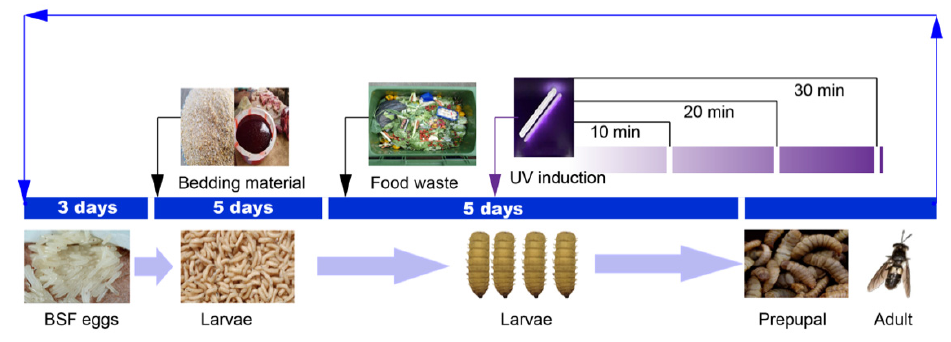
Figure 6. Schematic diagram of experimental design.